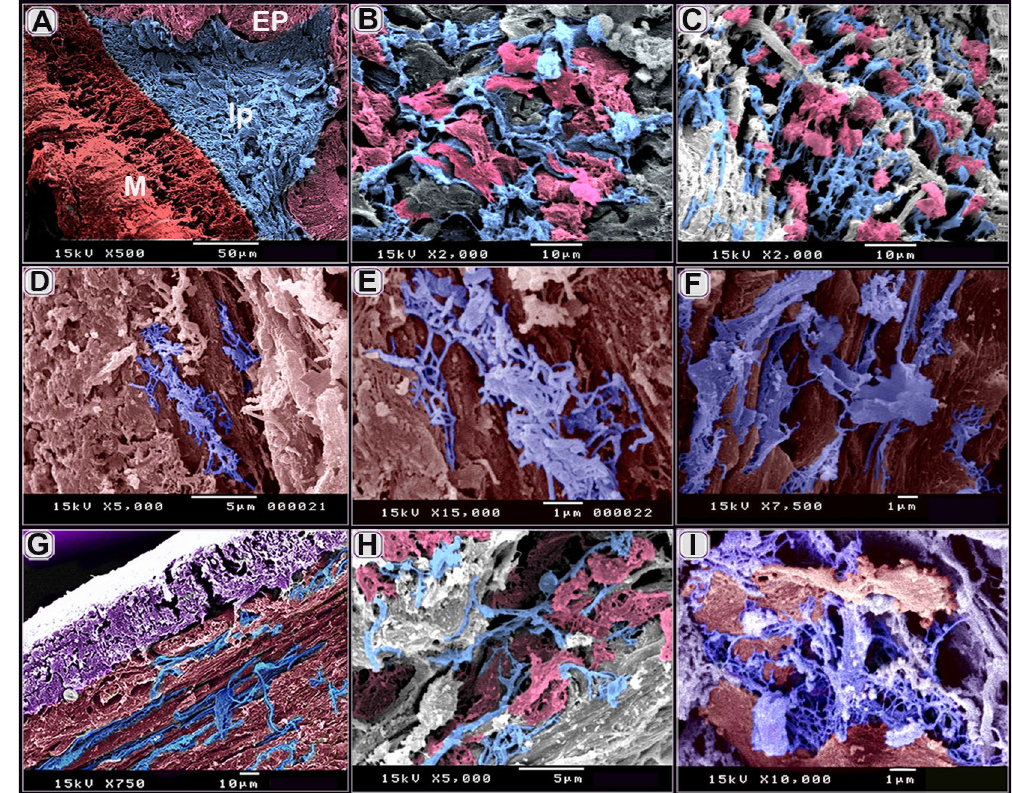
Figure 14. Scanned muscular TCs. ( A ) scanned sample of the intestinal blub. Note the epithelium (ep), lamina propria (lp, telocytes (blue color), muscle (m, reddish brown color). ( B , C ) TCs network (blue colored) in the lamina propria. Note connected teloped (pink colored). ( D – F ) TCs (blue colored) between muscle bundles (red colored). ( G , I ) TC network between muscle fibers (brown colored). Note connetced teloped (pink colored). ( H ) TCs (blue color) in serosa.